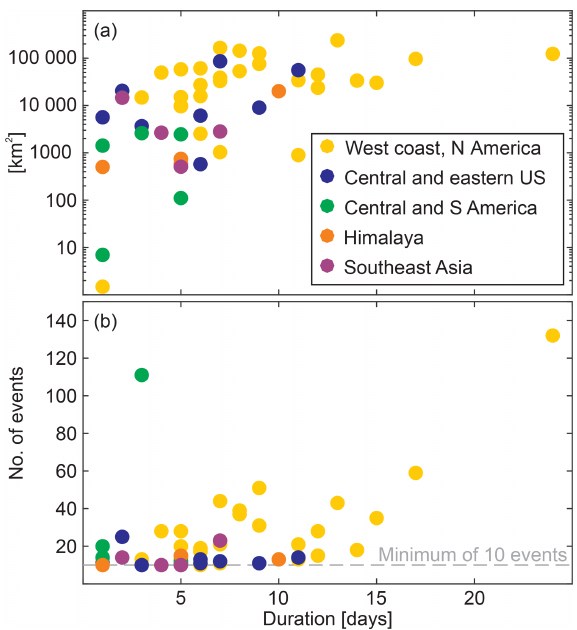
Figure 5. Link between the duration of the individual clusters ≥ 10 events and (a) the covered area and (b) the number of landslide events per cluster. The color of the scatter plots indicates the region in which each cluster